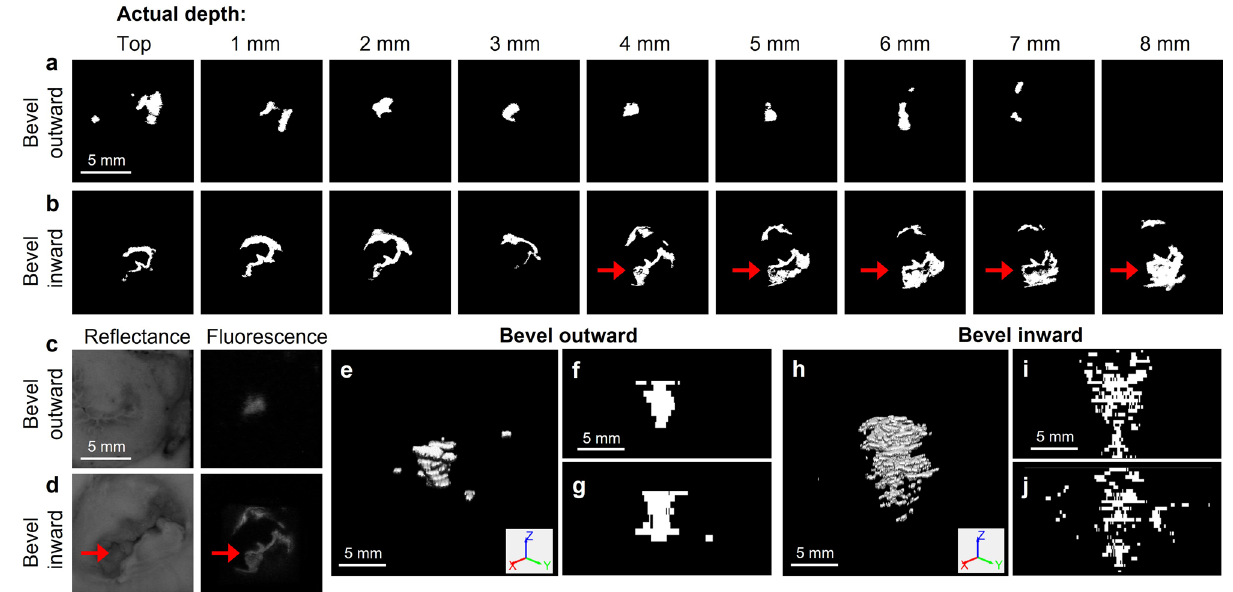
Figure 2. Representative thresholded fluorescein images from an ex vivo swine injection as a function of actual needle depth (27-gauge needle, 7.6 mm insertion depth, 10 mm/s insertion rate, 6% EC-ethanol, 10 mL/h infusion rate, and 200 µL infusion volume) in which the needle bevel was facing ( a ) outward to the outer edge of the cervix and ( b ) inward towards the os. Five minutes post injection, the tissue was flash frozen and subsequently sectioned with a cryostat and imaged at various depths (starting from the top of the sample and moving downward into the sample). Red arrows indicate leakage into the os, which was localized by comparing reflectance images to the corresponding fluorescence images. Representative reflectance and fluorescence images from a 4 mm depth when the bevel was facing ( c ) outward and ( d ) inward. ( e ) 3D rendering of reconstructed volume of the injection in which the needle bevel was facing outward and slice through the center of the ( f ) XZ and ( g ) YZ planes. ( h ) 3D rendering of reconstructed volume of the injection in which the needle bevel was facing inward and slice through the center of the ( i ) XZ and ( j ) YZ planes. Scale bars are 5